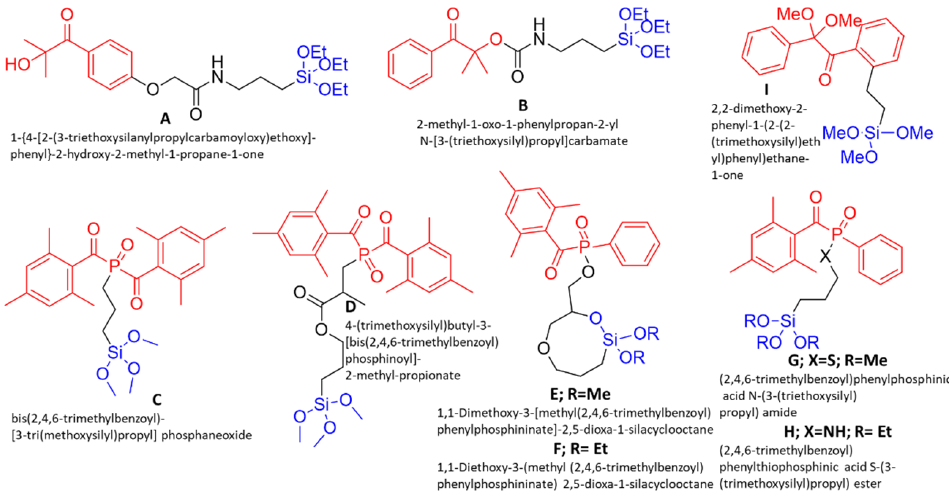
Figure 5. Type I photoinitiators (red) bearing a silane coupling unit (blue) for surface tethering.